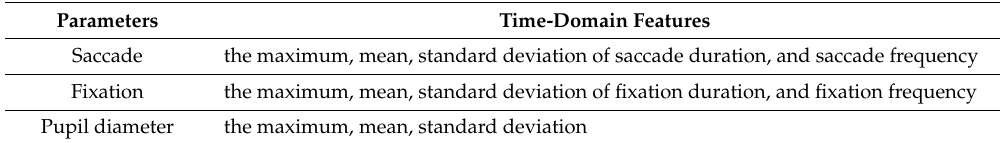
Table 1. Time-domain Eye Movement Features.